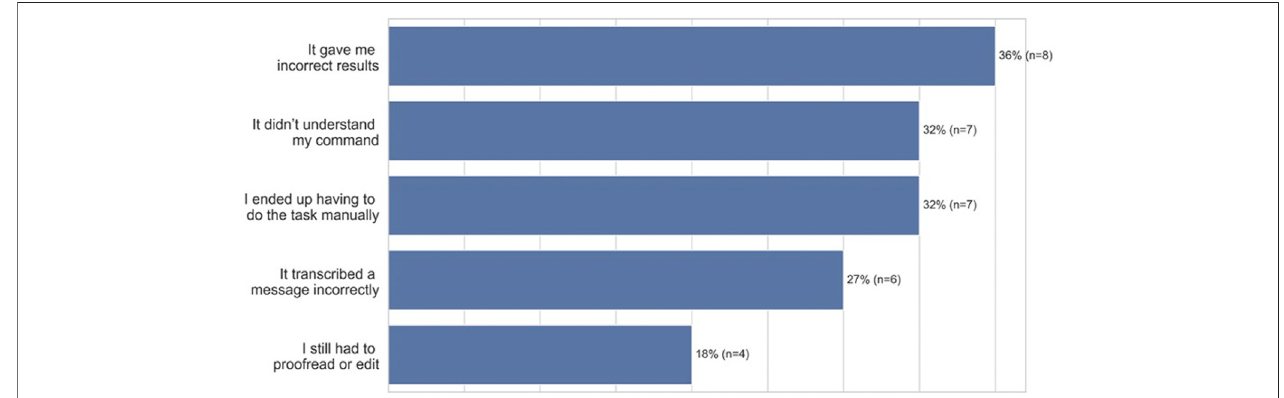
FIGURE 2 | Why African American participants aren ’ t satis fi ed ( n (cid:1) 22).